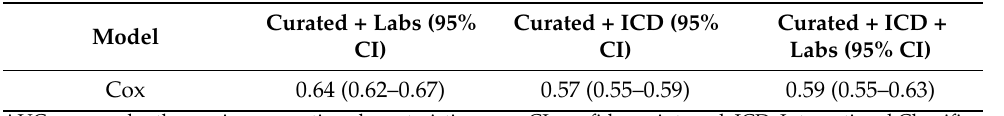
Table A4. Cox model performance (AUC) with two-way interactions using a stepwise variable selection approach with different datasets.